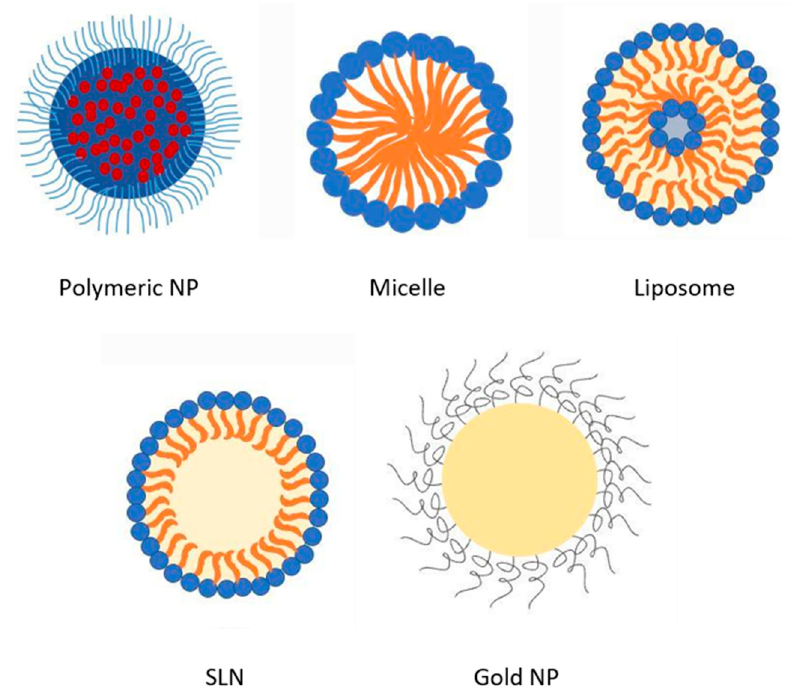
Figure 1. Nanoformulations under investigation for the oral delivery of AmpB.